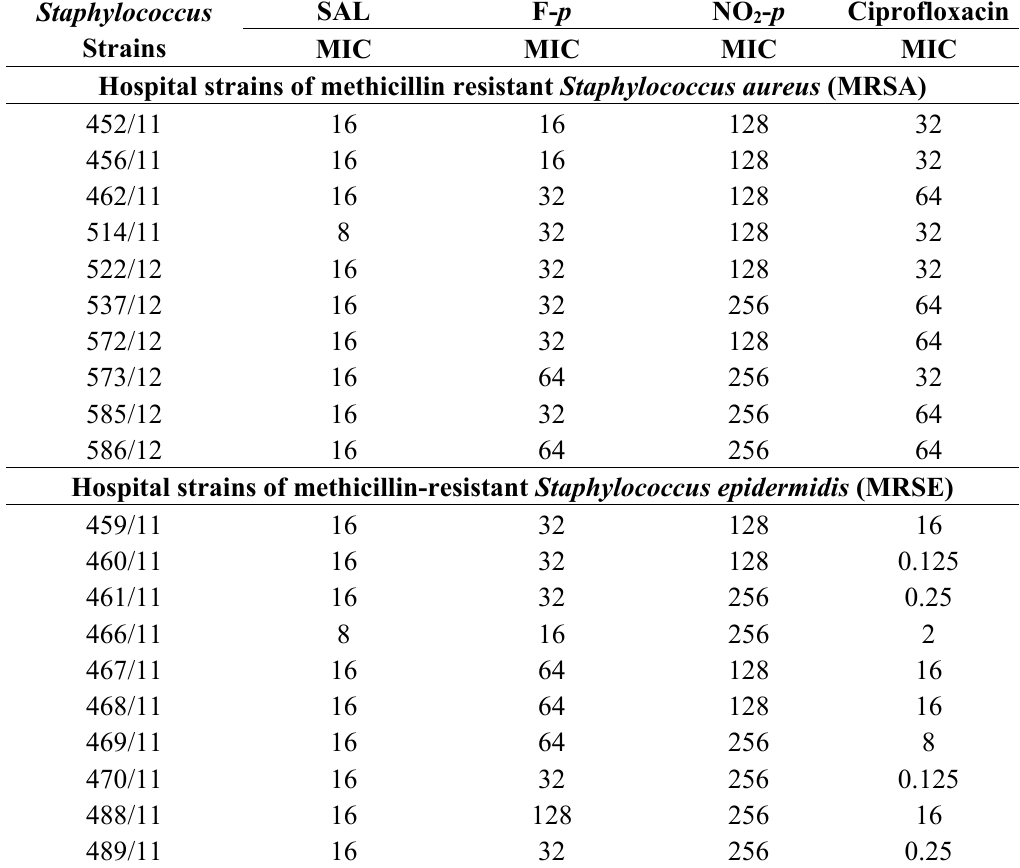
Table 6. Antibacterial activity of SAL as well as its F- p and NO and MRSE designated as MIC